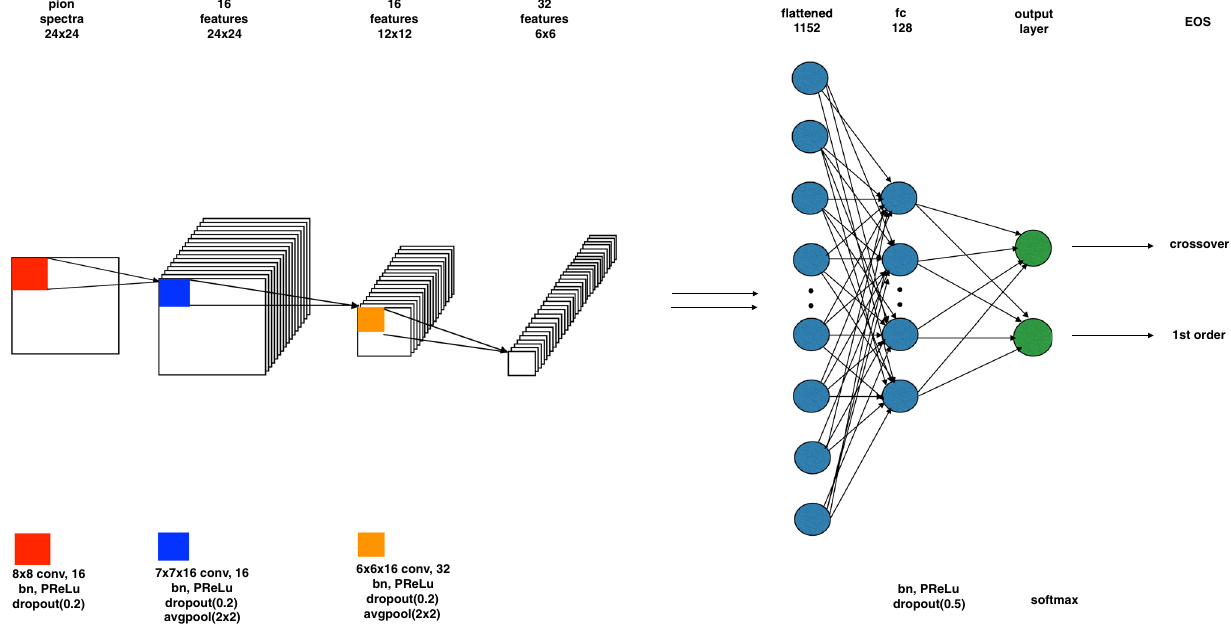
Fig. 4 The architecture of our convolution neural network (CNN) for identifying the QCD transition type by using pion spectra with 24 transverse momentum p T bins and 24 azimuthal angle (cid:6)